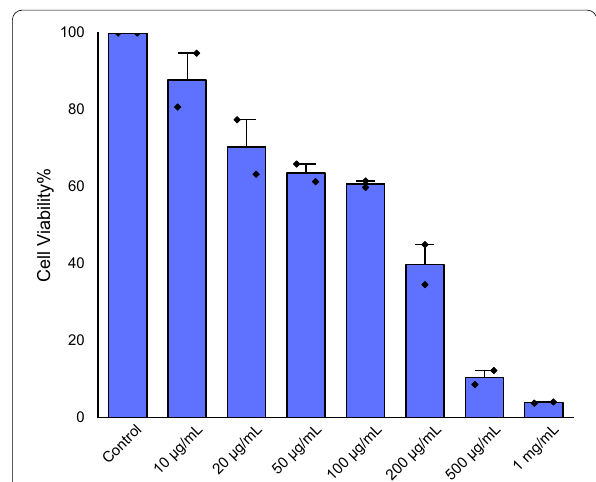
Fig. 9 The cell viability percentage of HPEG2 after being treated with various concentrations of Au @ AgNPs (10, 20, 50, 100, 200, 500 and 1000 µg/mL). The results represent the means of three replicates, with two biological replicates and the error bars represent the standard error of the